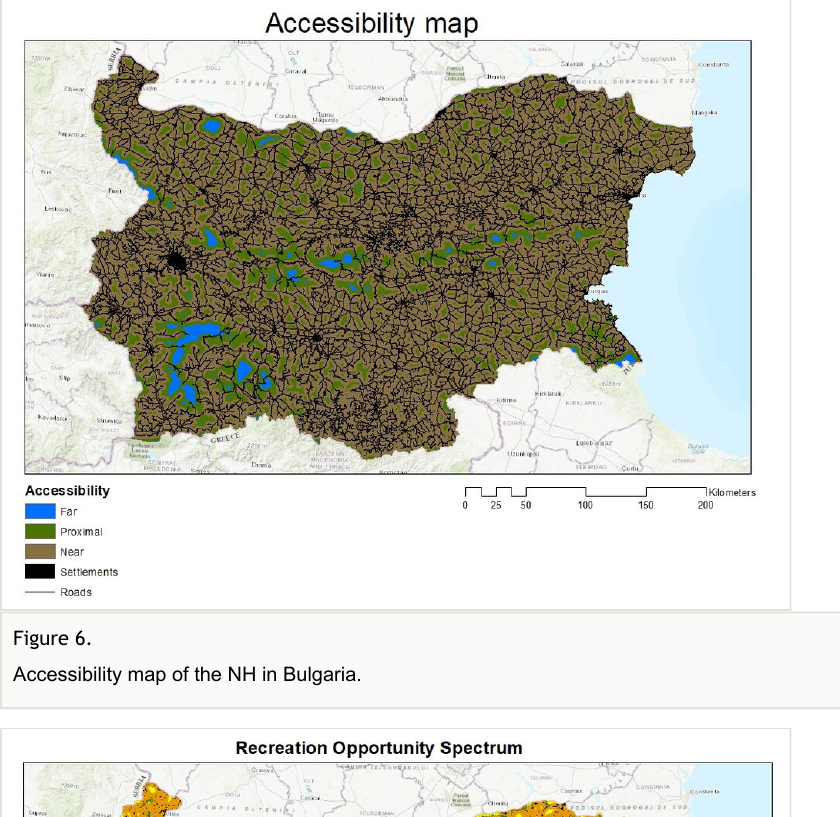
Figure 6. Accessibility map of the NH in Bulgaria.